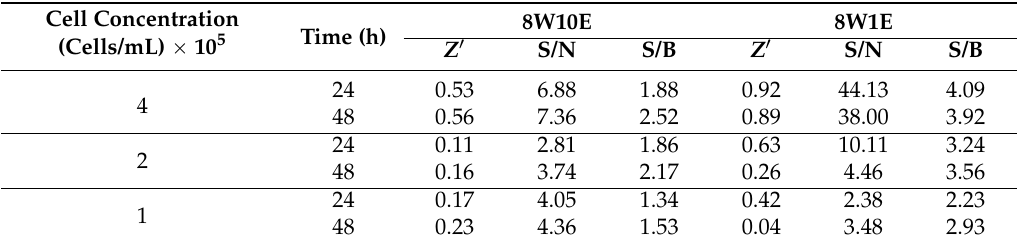
Table 1. Summary of the statistical parameters: screening window coefficient ( Z 1 ), signal-to-noise (S/N) and signal-to-background (S/B), measured during the optimization assays conducted in uncoated 8W1E and 8W10E